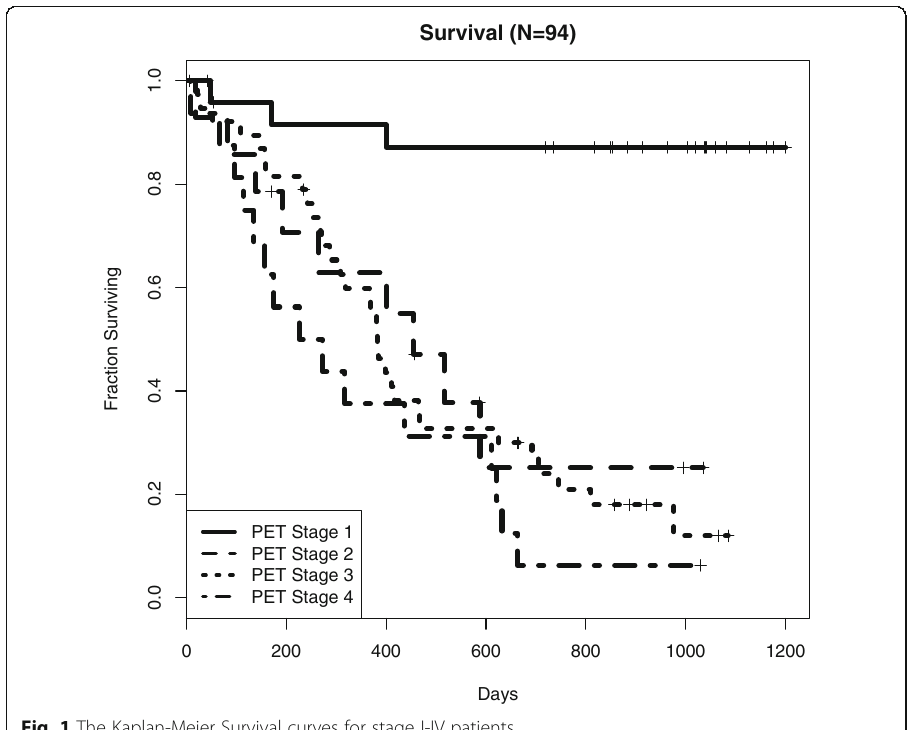
Fig. 1 The Kaplan-Meier Survival curves for stage I-IV patients